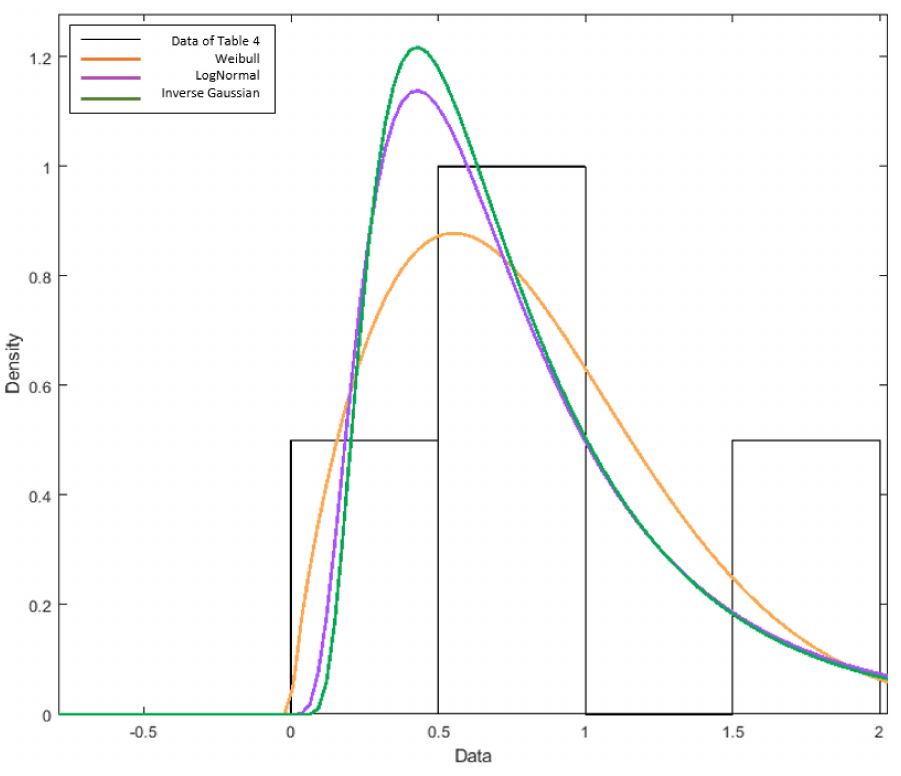
Figure 4. SDF for the dataset of Table 2 for the case of Kimmeria, Xanthi.